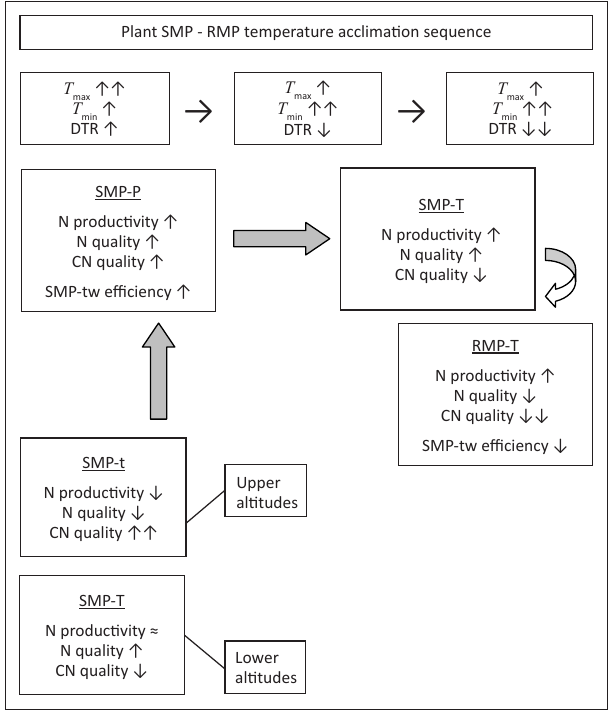
FIGURE 6: Sustained metabolic performance (SMP) to resource-responsive metabolic performance (RMP) mode temperature acclimation sequence involving four phase states: an initial SMP productivity pulse (SMP-t/SMP-T → SMP-P) followed by temperature acclimation (SMP-t/SMP-P → SMP-T → RMP-T) along the SMP-RMP acclimation trajectory (Figure 5) of intraspecific plant metabolic responses to temperature